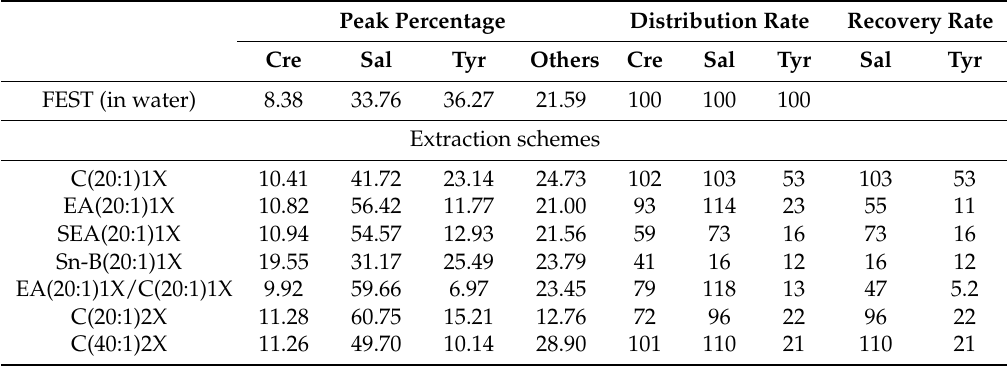
Table 2. Influence of various combinations of solvents on separation of crenulatin, salidroside, and p -tyrosol by liquid-liquid extraction (% in water). Peak Percentage Distribution Rate Recovery Rate Cre Sal Tyr